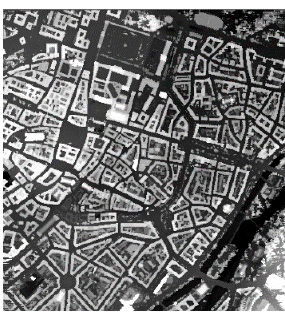
Figure 3. Munich aireal photography